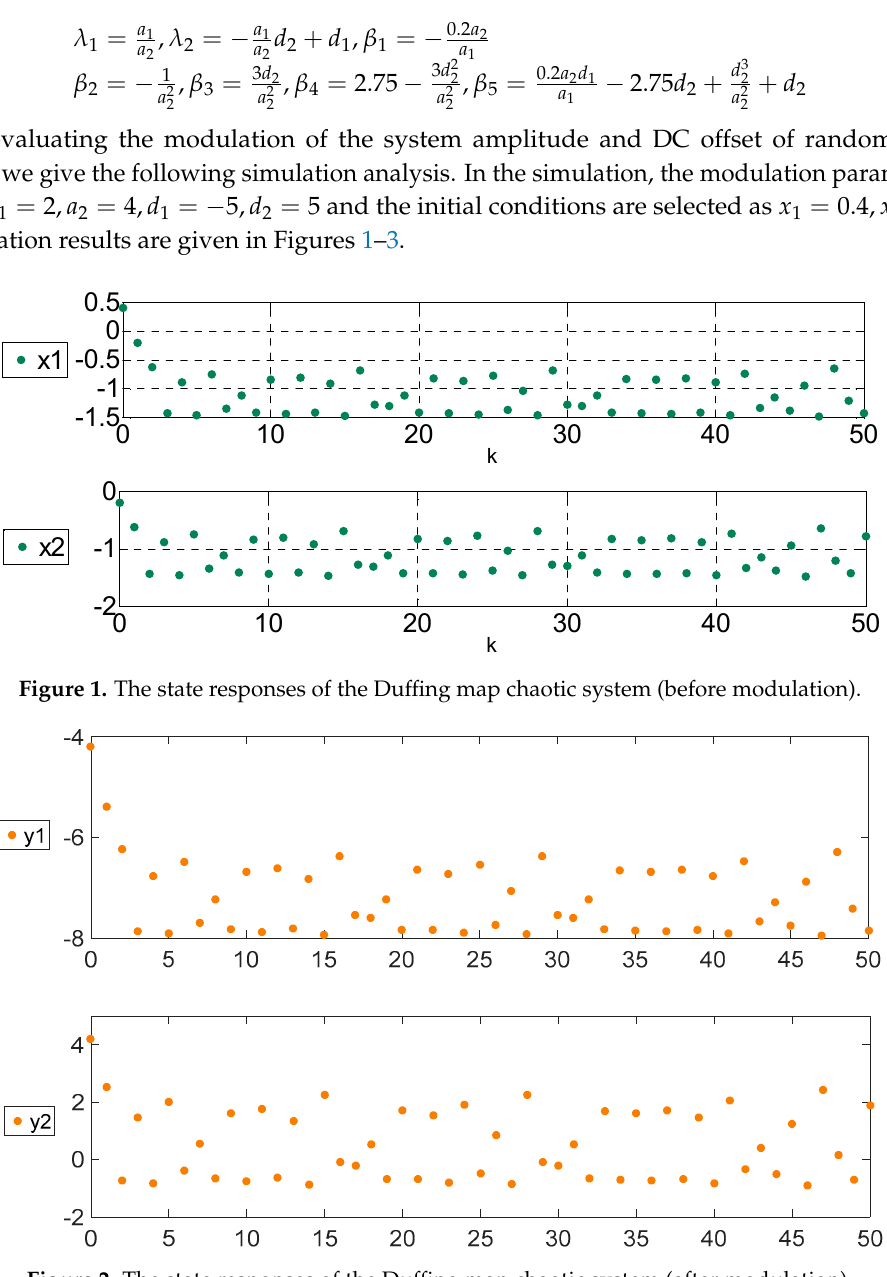
Figure 2. The state responses of the Duffing map chaotic system (after modulation).